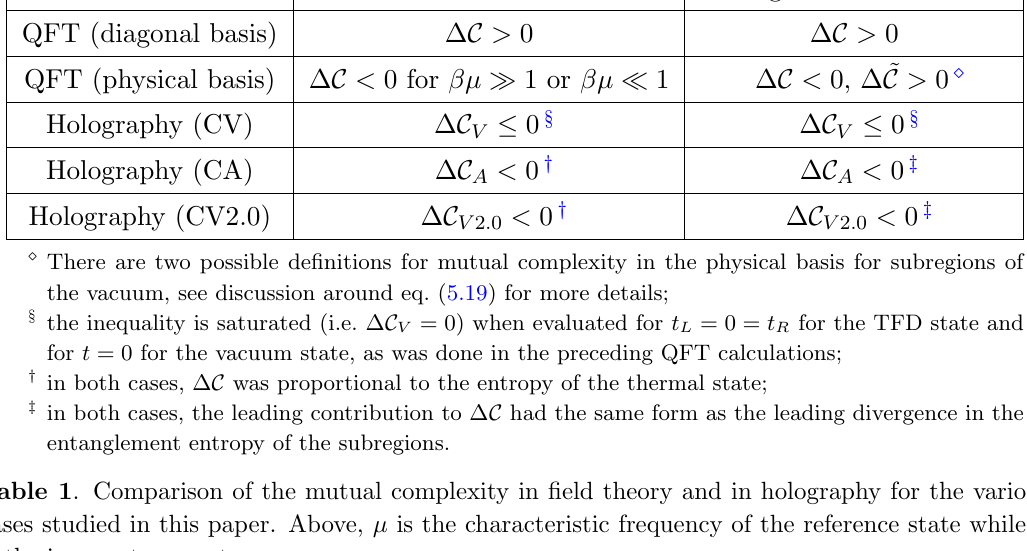
Table 1 . Comparison of the mutual complexity in (cid:12)eld theory and in holography for the various cases studied in this paper. Above, (cid:22) is the characteristic frequency of the reference state while (cid:12) is the inverse